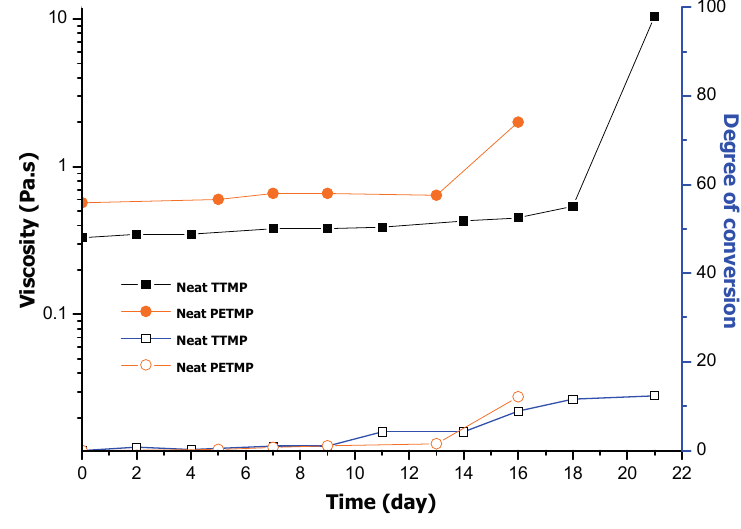
Figure 5. Plot of viscosities and degree of curing achieved of the different DGEBA formulations with tri- and tetrathiol against storage time. Filled symbols represent the viscosity and open symbols represent the degree of